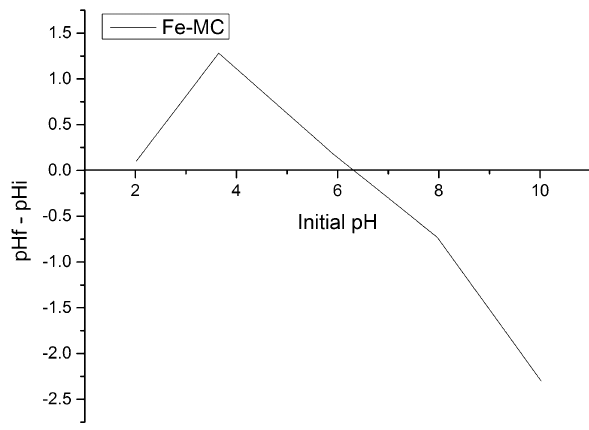
Fig. 9 Point of zero charge (pH